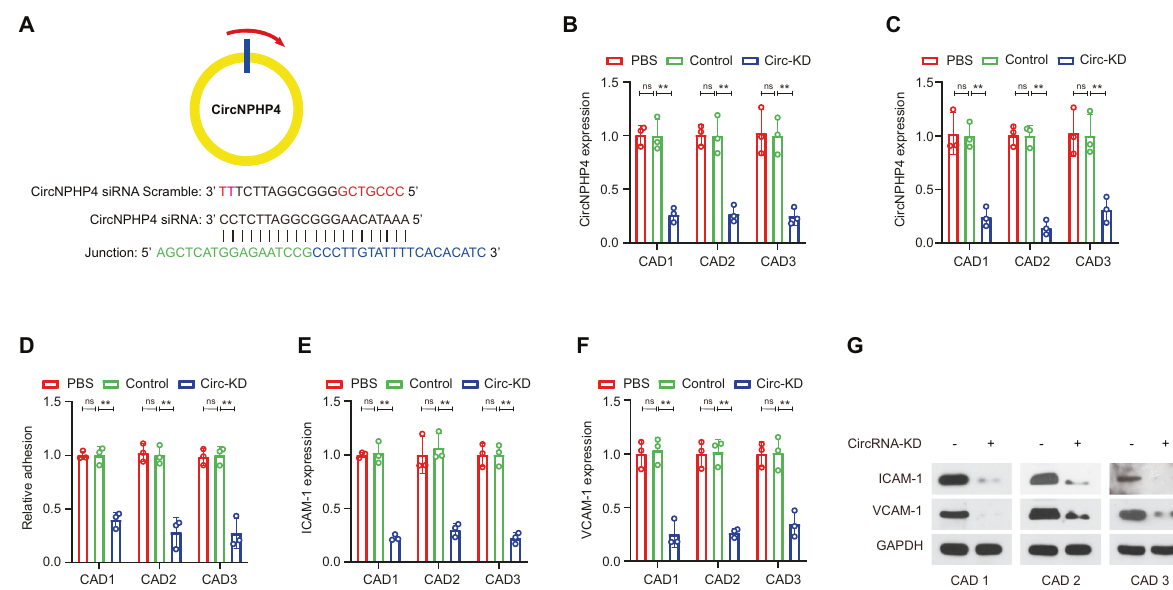
Fig. 5 CircNPHP4 from monocyte-derived sEVs promoted heterogeneous adhesion. A Schematic representation of the siRNA sites speci fi c to the back-splice junction of circNPHP4. Expression of circNPHP4 following siRNA treatment using qRT-PCR in monocytes ( B ) and in sEVs from monocytes ( C ). Heterogeneous adhesion was analyzed after transfection with circNPHP4 speci fi c siRNA versus scramble controls ( D ). ICAM-1 ( E ) and VCAM-1 ( F ) were detected in HCAECs exposed to sEVs from circNPHP4-knockdown monocytes, as quanti fi ed by qRT-PCR and western blot analyses ( G ). Data are presented as means ± SD; a signi fi cant difference was identi fi ed with Student ’ s t test. * P < 0.05; ** P < 0.01; ns (not signi fi